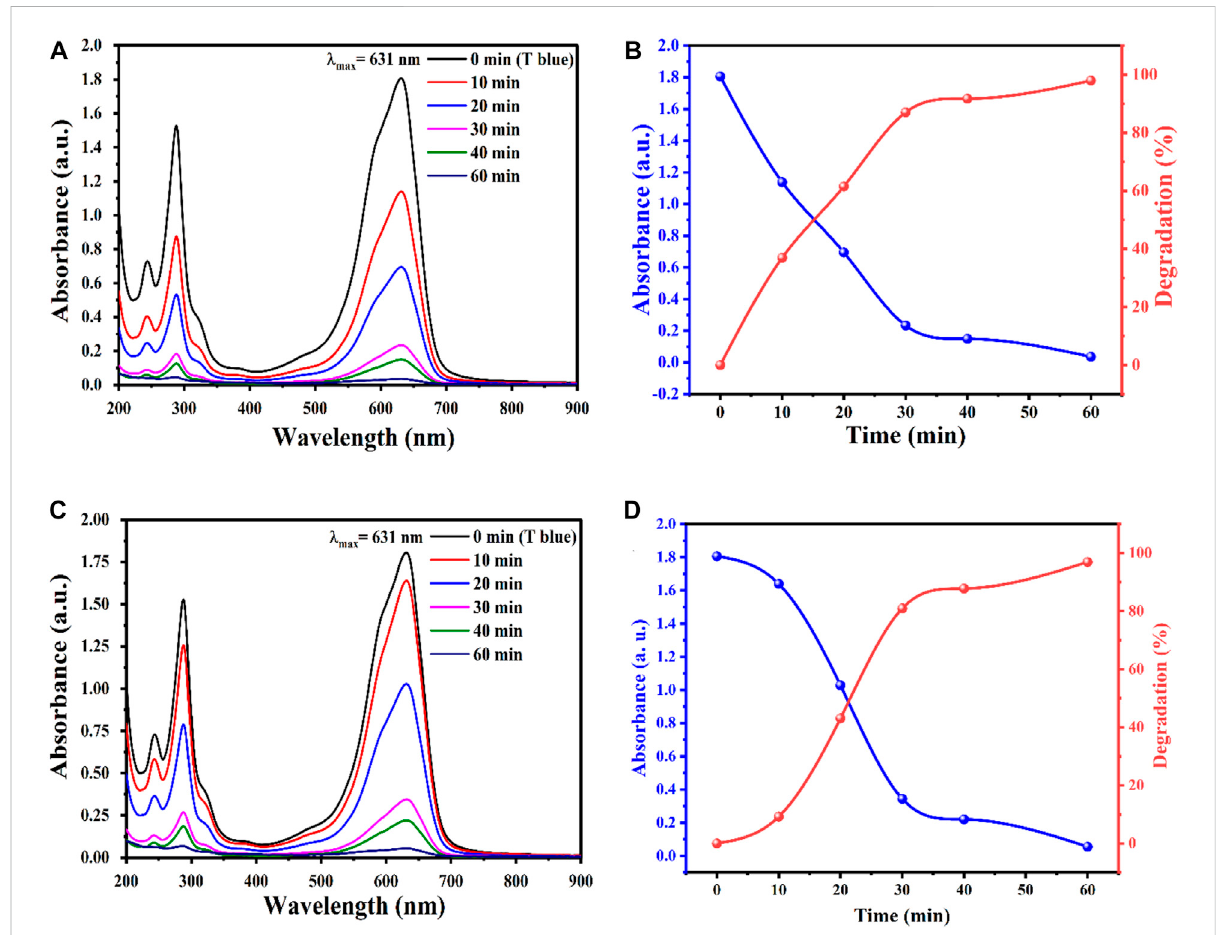
FIGURE 8 The effect of reaction time on degradation of TB, obtained by (A) AgO/Ag 2 O, Absorbance and degradation versus time: (B) AgO/Ag 2 O, (C) MgO@AgO/Ag 2 O; (D) MgO@AgO/Ag 2 O NPs catalyzed degradation of TB